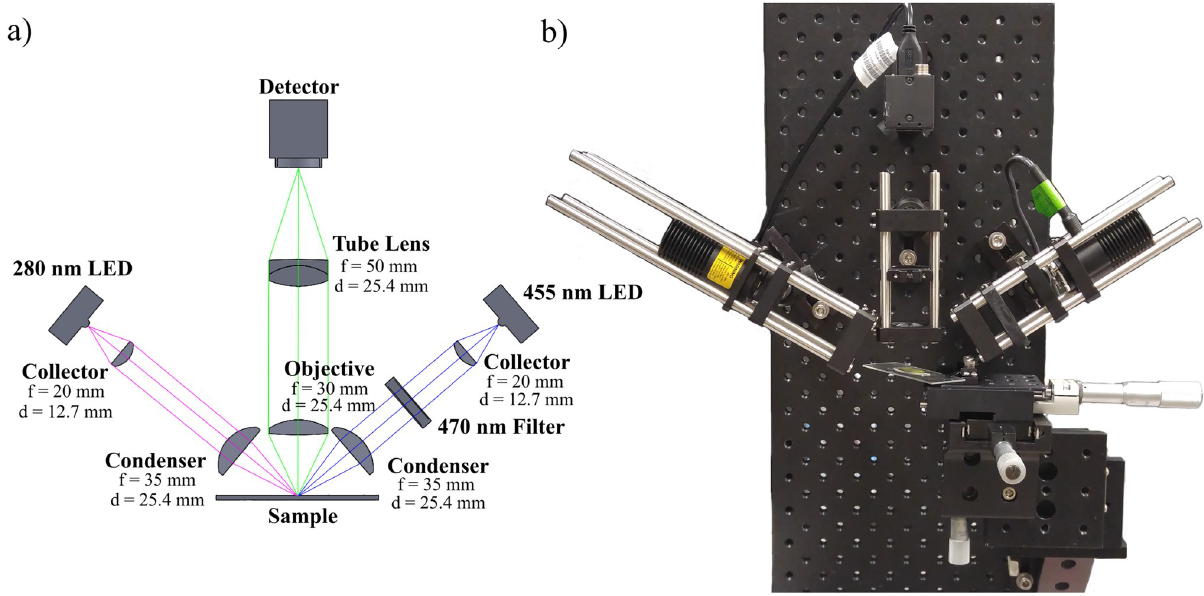
Fig 1. Optical schematic and image of the UV fluorescence microscope system. (a) Optical schematic of the designed UV microscope and (b) image of the fully assembled system. Samples were mounted on an xyz stage to enable focus adjustment and lateral scanning.